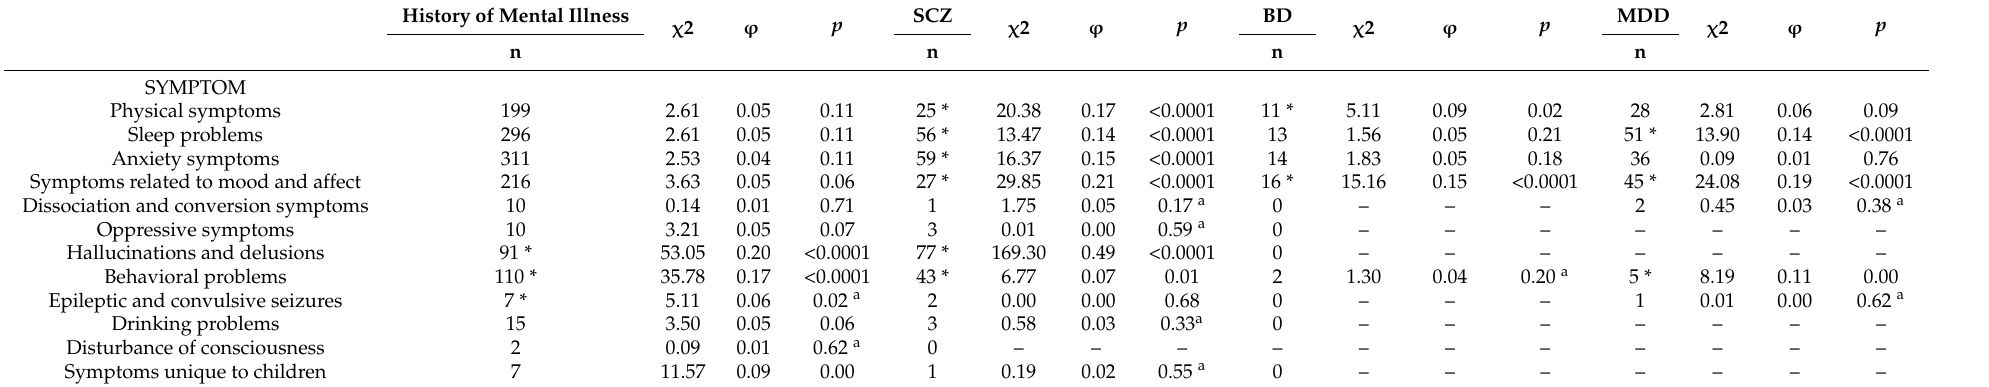
Table 3. Comparison of symptoms among pre-existing severe mental illness.